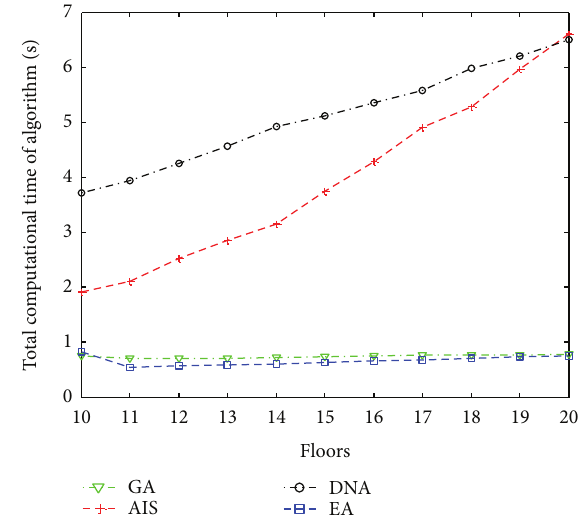
Figure 12: Total computational time of algorithms.